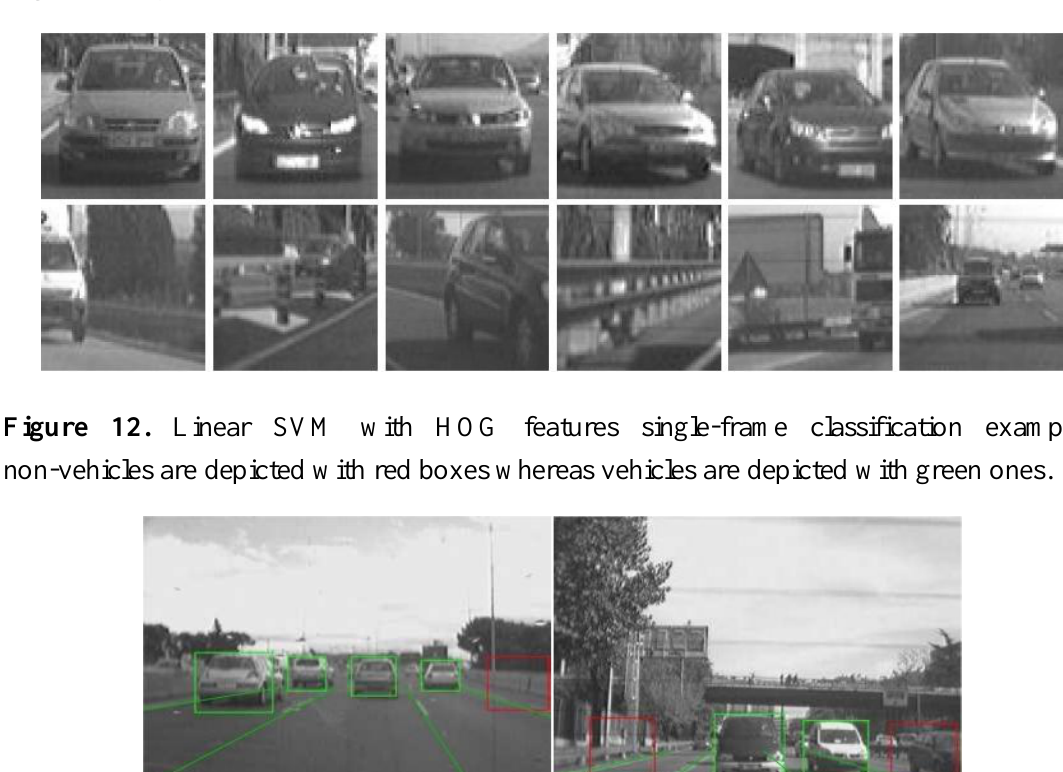
Figure 11. Rear data set. Upper row: positive samples (vehicles); Lower row: negative samples.